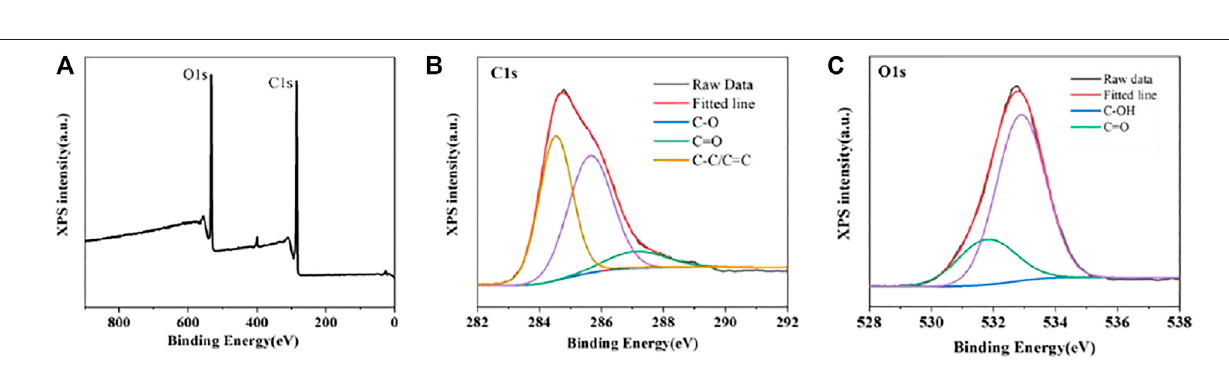
Frontiers in Chemistry |